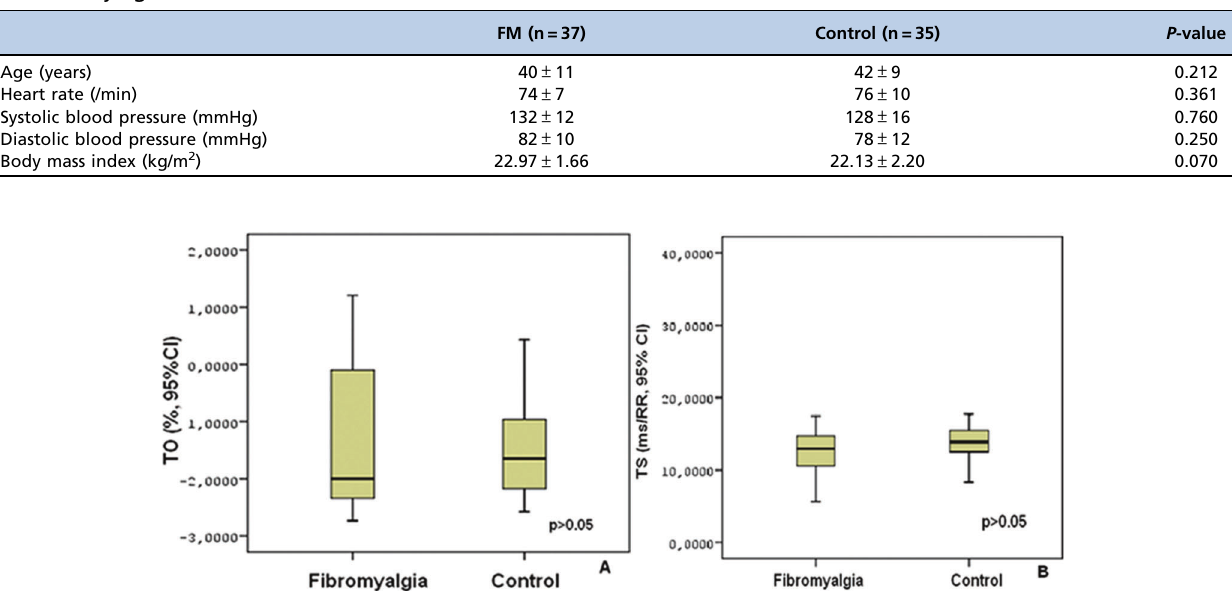
Figure 1 - Turbulence Onset (A) and Turbulence Slope (B) values of the two study groups with confidence